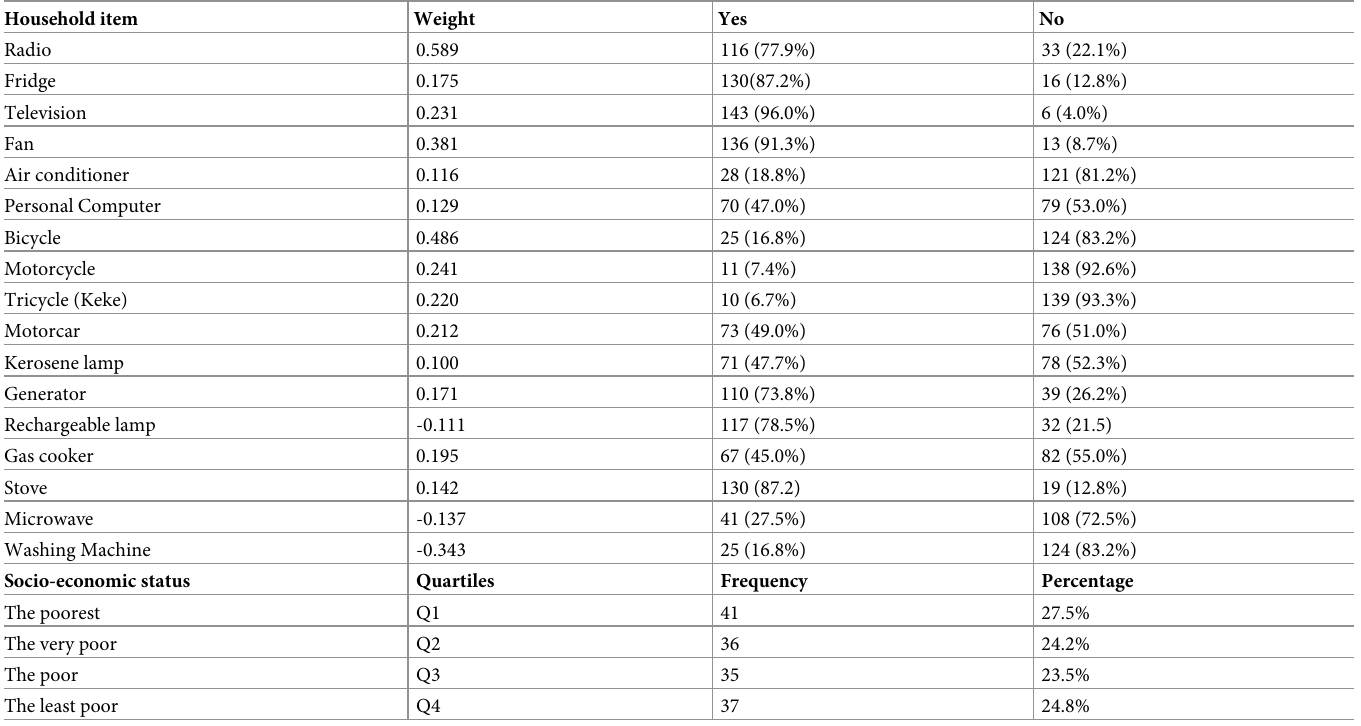
Table 4. Socioeconomic status as represented by household items owned by respondents on assets based index (n = 149).